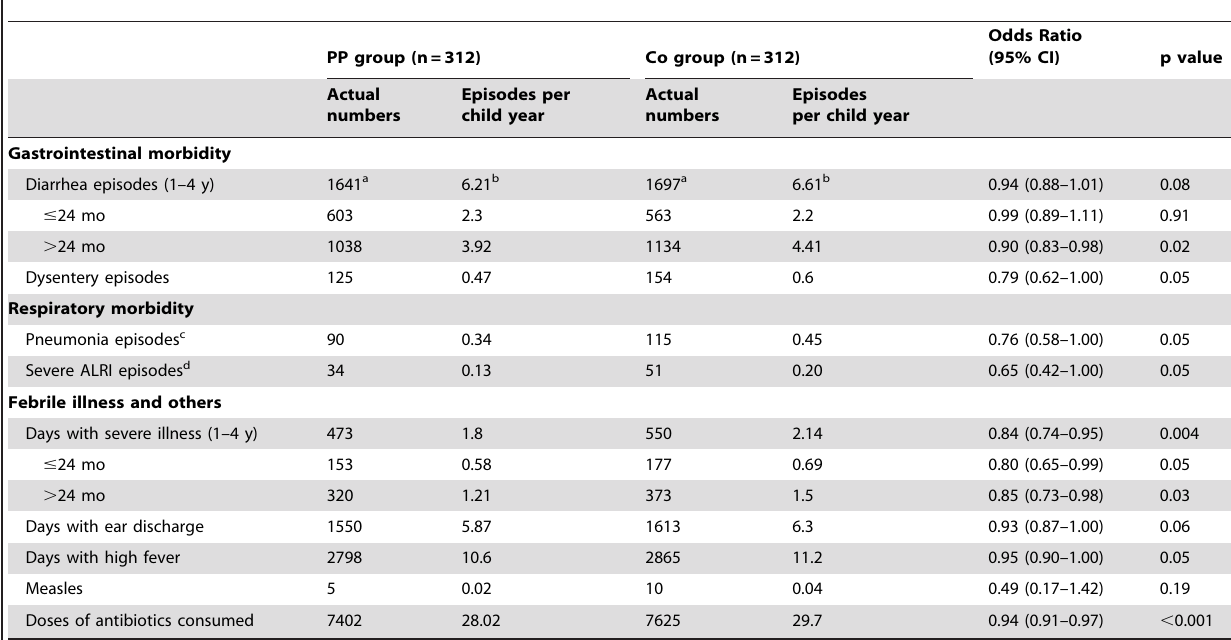
Table 3. Effect of prebiotic oligosaccharide and probiotic Bifidobacterium lactis HN019 fortified milk on common childhood